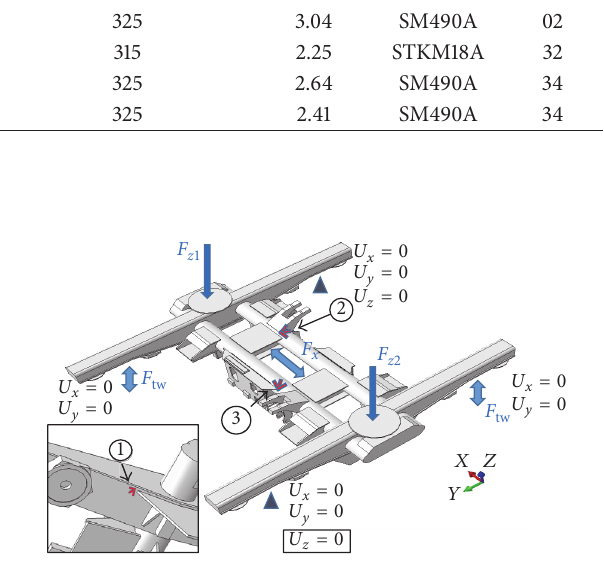
Figure 5: Load conditions and strain gauge